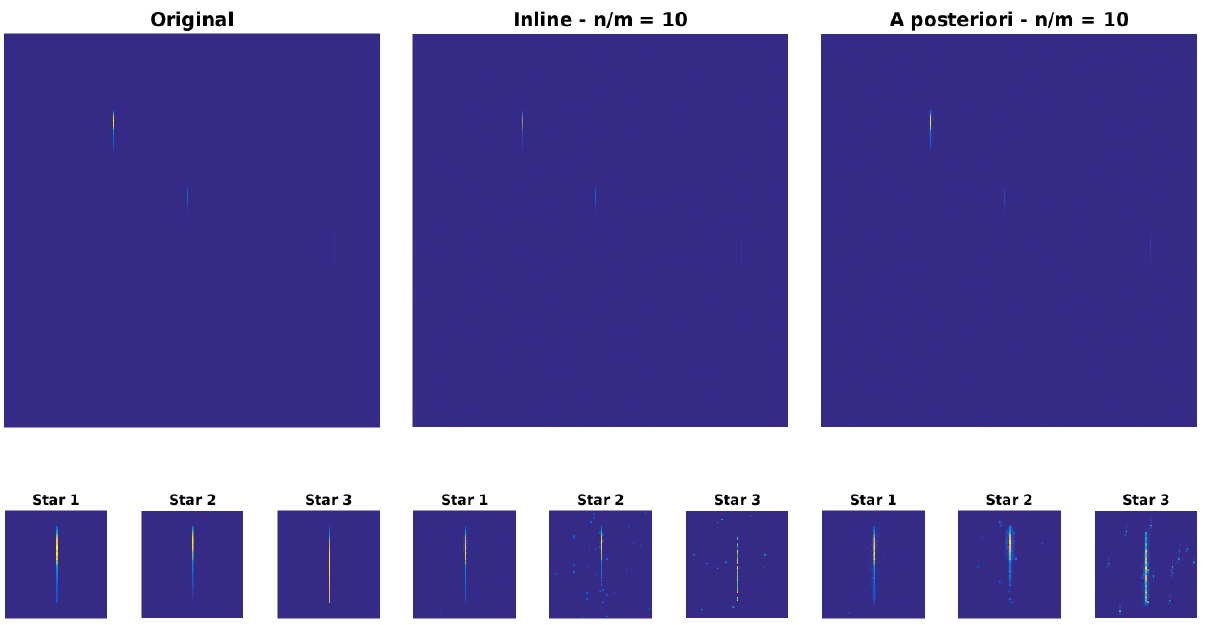
Figure 10. Image reconstruction (n/m = 10): comparison between the original image, the reconstructed image with inline MTF compensation, and the reconstructed image with a posteriori compensation of the MTF after the image reconstruction.